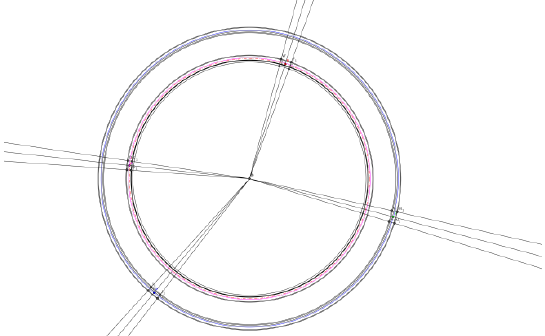
Figure 7: The geometric loci of each corner of a room as a function of all the measurements.